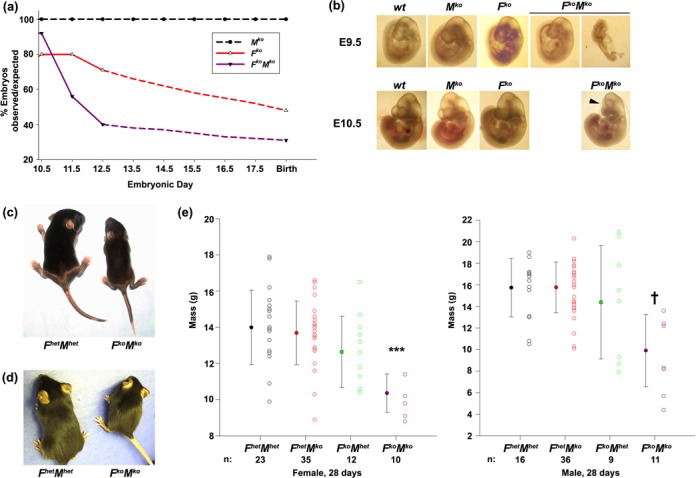
Increased embryonic lethality and growth delay in FkoMko mice. (a) Percentage of observed/expected FkoMko, Fko and Mko embryos/embryonic day (solid line) and projected survival (dashed line). (b) Representative images of developmental delays in FkoMko embryos at E9.5 and E10.5. Arrowhead, microcephaly. (c) Growth delay in FkoMko mice compared to sibling FhetMhet mice at 2 weeks of age. (d) Growth delay in FkoMko mice compared to sibling FhetMhet mice at 6 weeks of age. (e) Mass of female and male FhetMhet, FhetMko, FkoMhet and FkoMko mice at 4 weeks of age. Open circles represent each mouse assessed, solid circles represent mean mass for each group. Error bars represent ± standard deviation (SD), n values on the x-axis denote sample sizes. For the female cohort, ***P < 0.001 for FkoMko versus all genotypes by one-way ANOVA followed by Holm–Sidak post hoc test. For the male cohort, †P < 0.05 FkoMko versus FhetMhet or FhetMko by one-way ANOVA on ranks followed by Dunn's post hoc test.